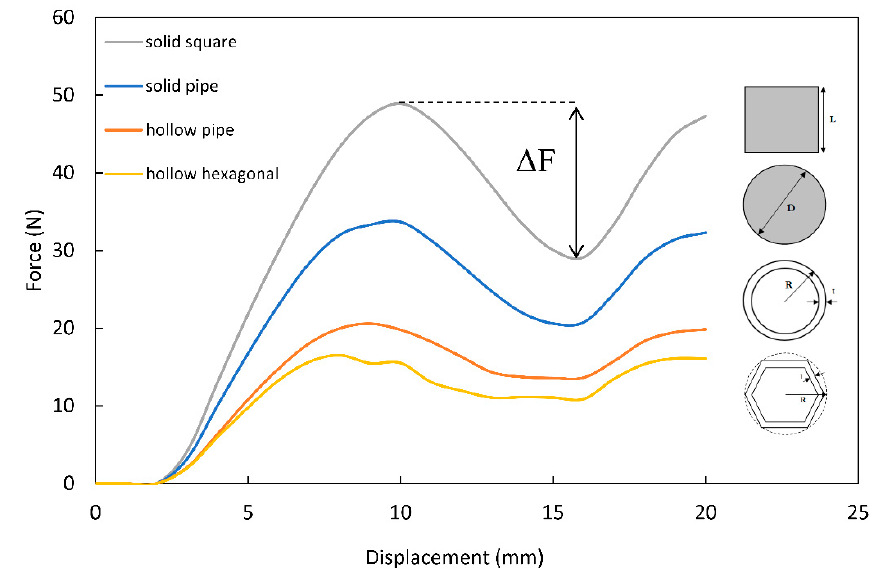
Figure 8. Effect of lattice members’ cross-sectional geometry on energy absorption. Table 4. Summary of stiffness, magnitude of ∆ F, and volumetric energy absorption efficiency η for various member with different cross-sectional geometries of H2 octet